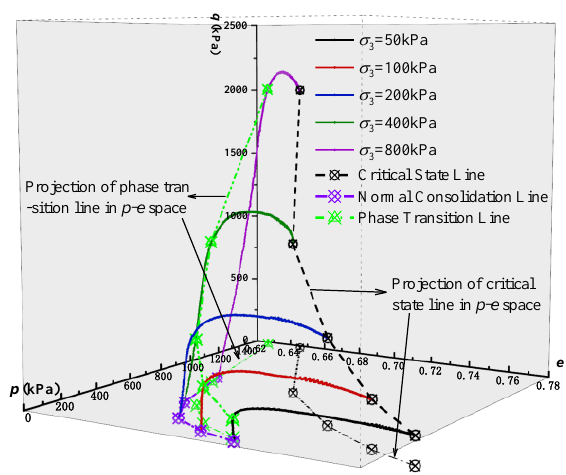
Figure 14. State boundary surface in three-dimensional space.